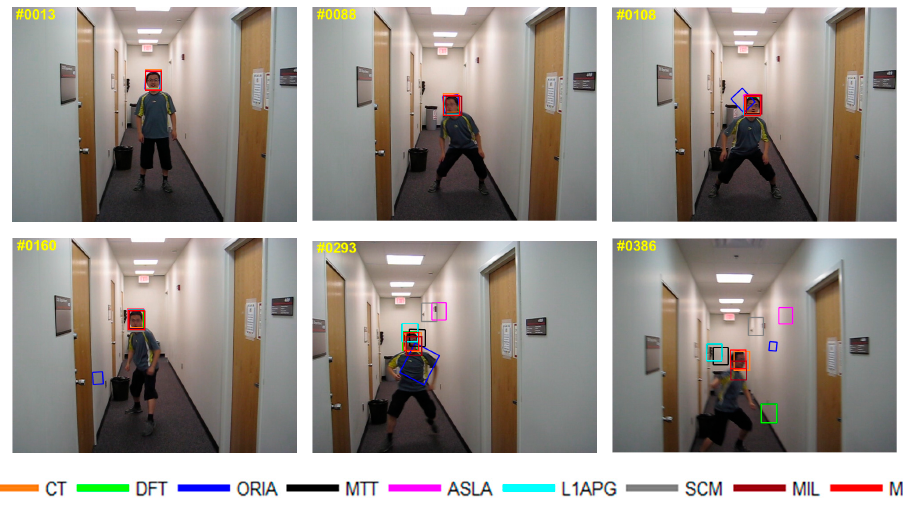
Figure 9. Tracking results on Boy .